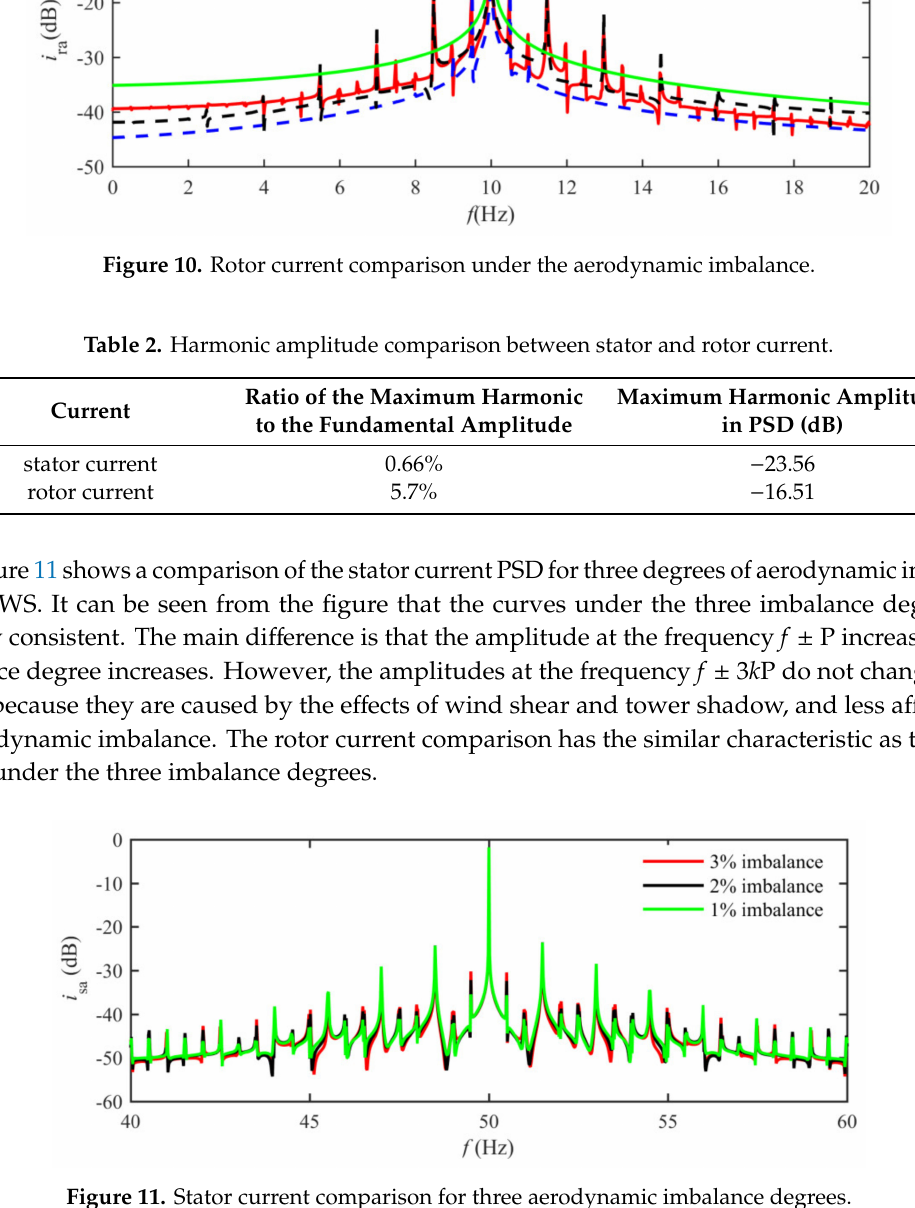
Figure 11. Stator current comparison for three aerodynamic imbalance